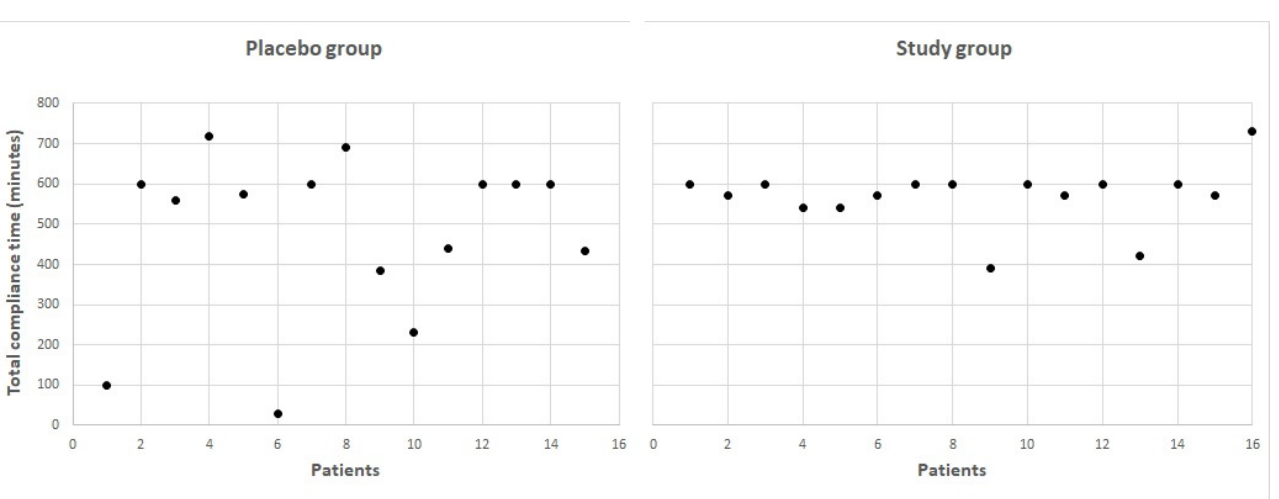
Table 2. Binocular VA characteristics of both groups before the training. Mean ± standard deviation (minimum and maximum) values for distance, intermediate, and near vision are represented by groups. Differences between groups were assessed by the Mann–Whitney test, and statistically significant differences ( p < 0.05) are marked with an asterisk (*). Distance, intermediate, and near vision were assessed at 4 m, 1 m, and 40 cm,